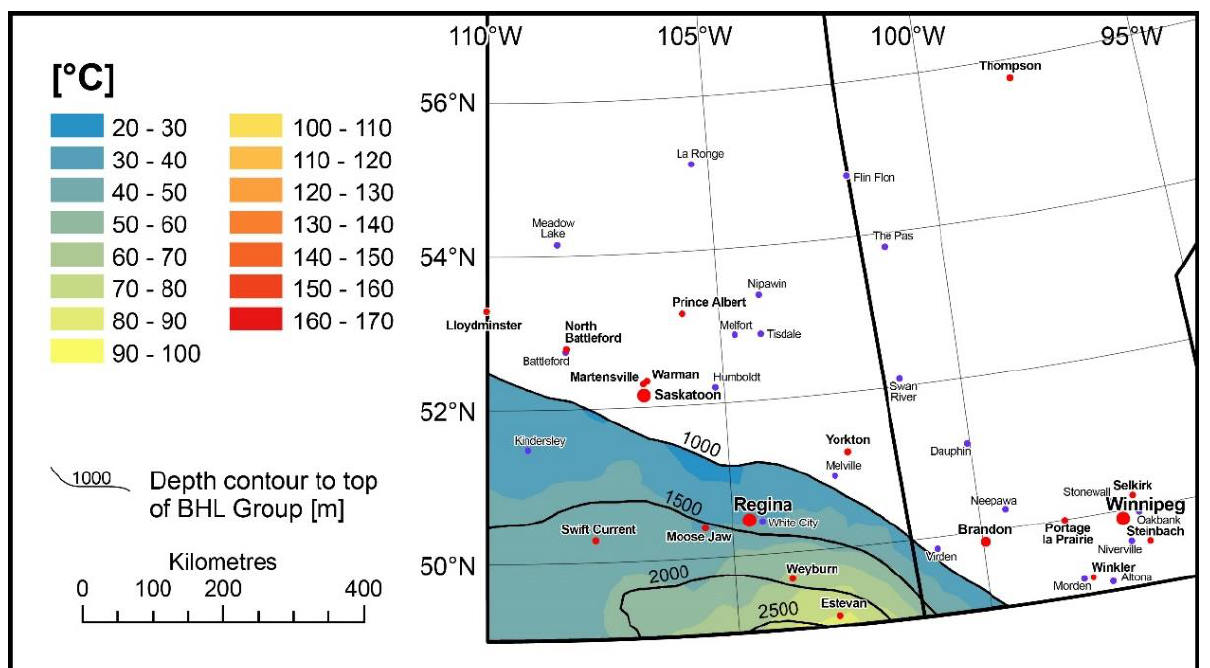
Figure A2. Temperatures top of Precambrian—Saskatchewan – Manitoba WCSB.